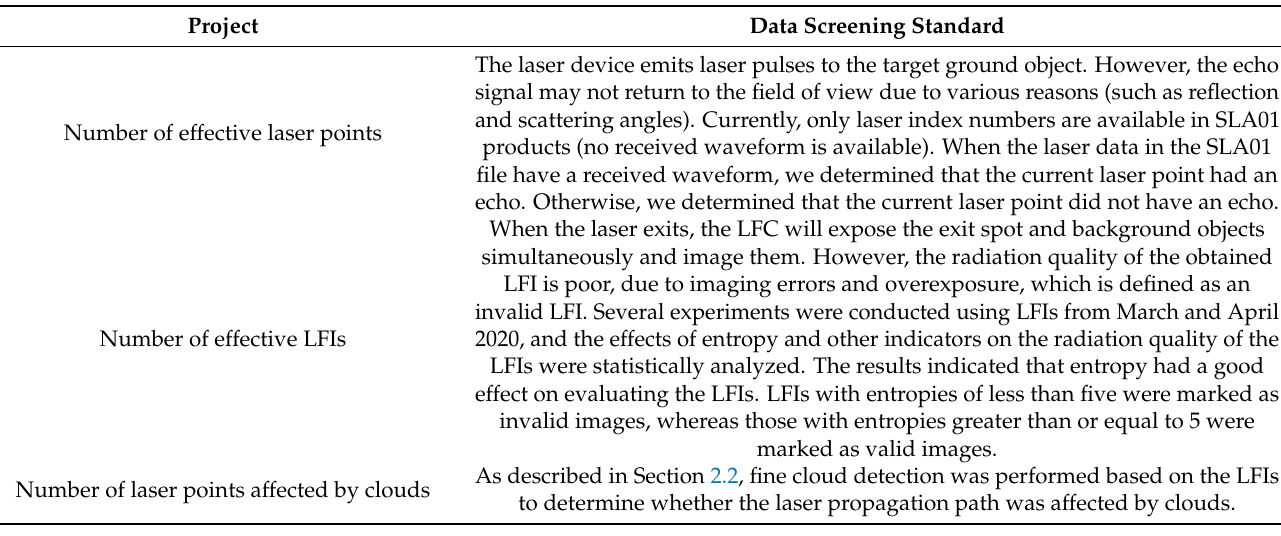
Table 3. Statistical index of laser data from the GF-7 satellite.